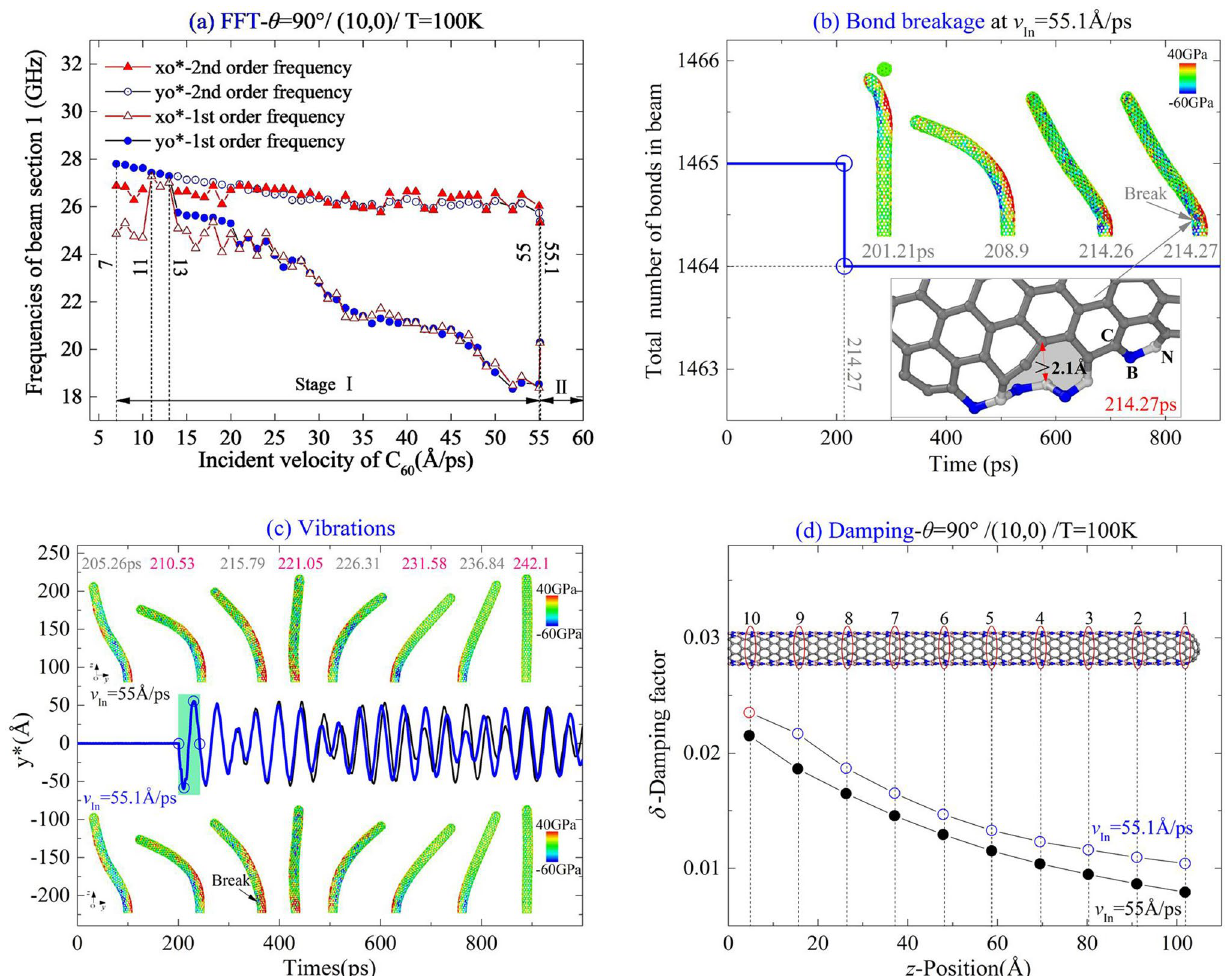
Figure 5. Vibration analysis of (10,0) nanobeam impacted by a high-speed C 60 along the path of θ = 90° at 100 K. ( a ) Natural frequencies of the beam impacted by the C 60 with different incident velocities. ( b ) At critical incident velocity, i.e.,